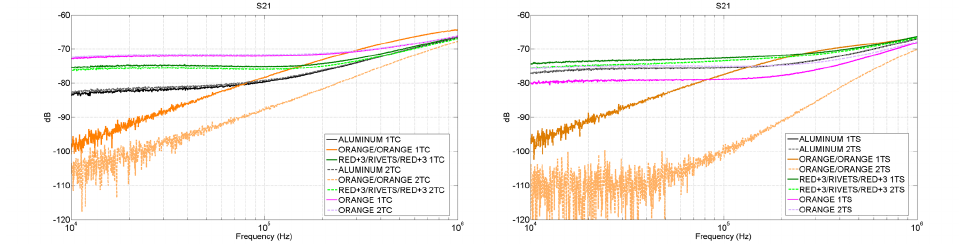
Figure 19. Microstrip surface current measurement: 1TC/2TC central sections of the sample ( left ) and 1TS/2TS side sections of the sample ( right